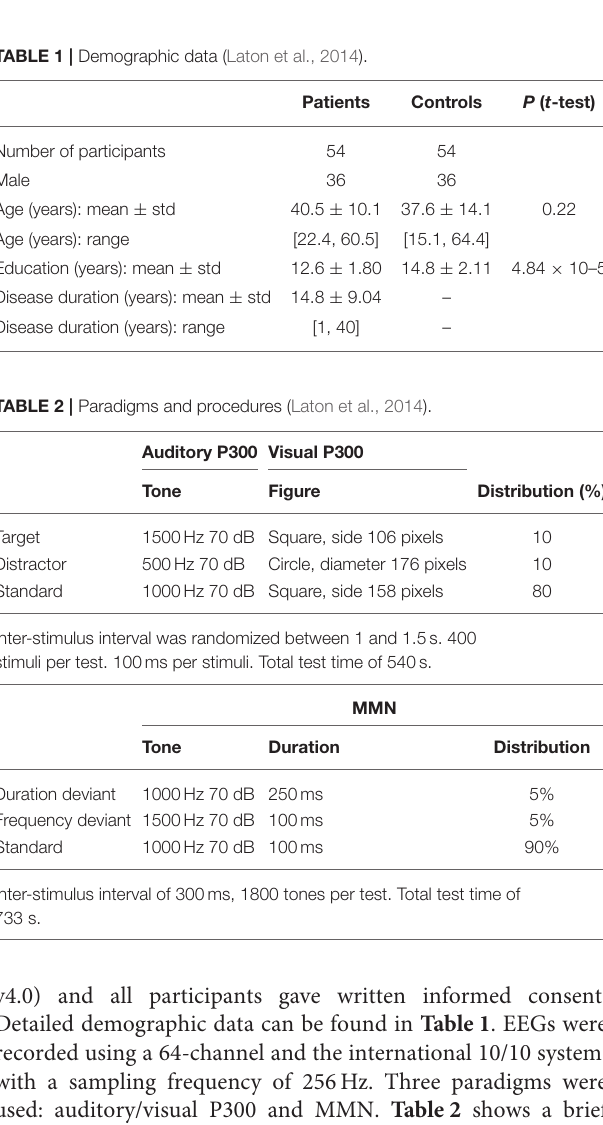
TABLE 1 | Demographic data (Laton et al., 2014).